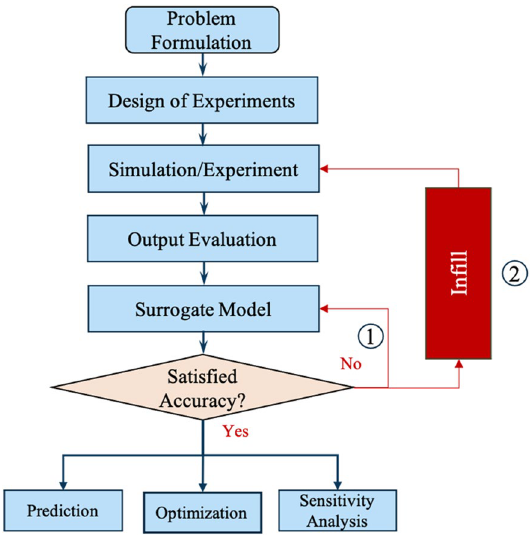
Figure 1 The workflow of conducting data-driven design